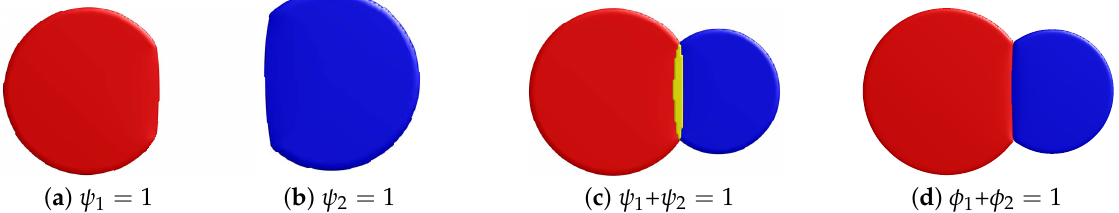
Figure 2. Reconstructed surface in the cut view. The red and blue regions represent the different materials. The yellow region represents the overlapping